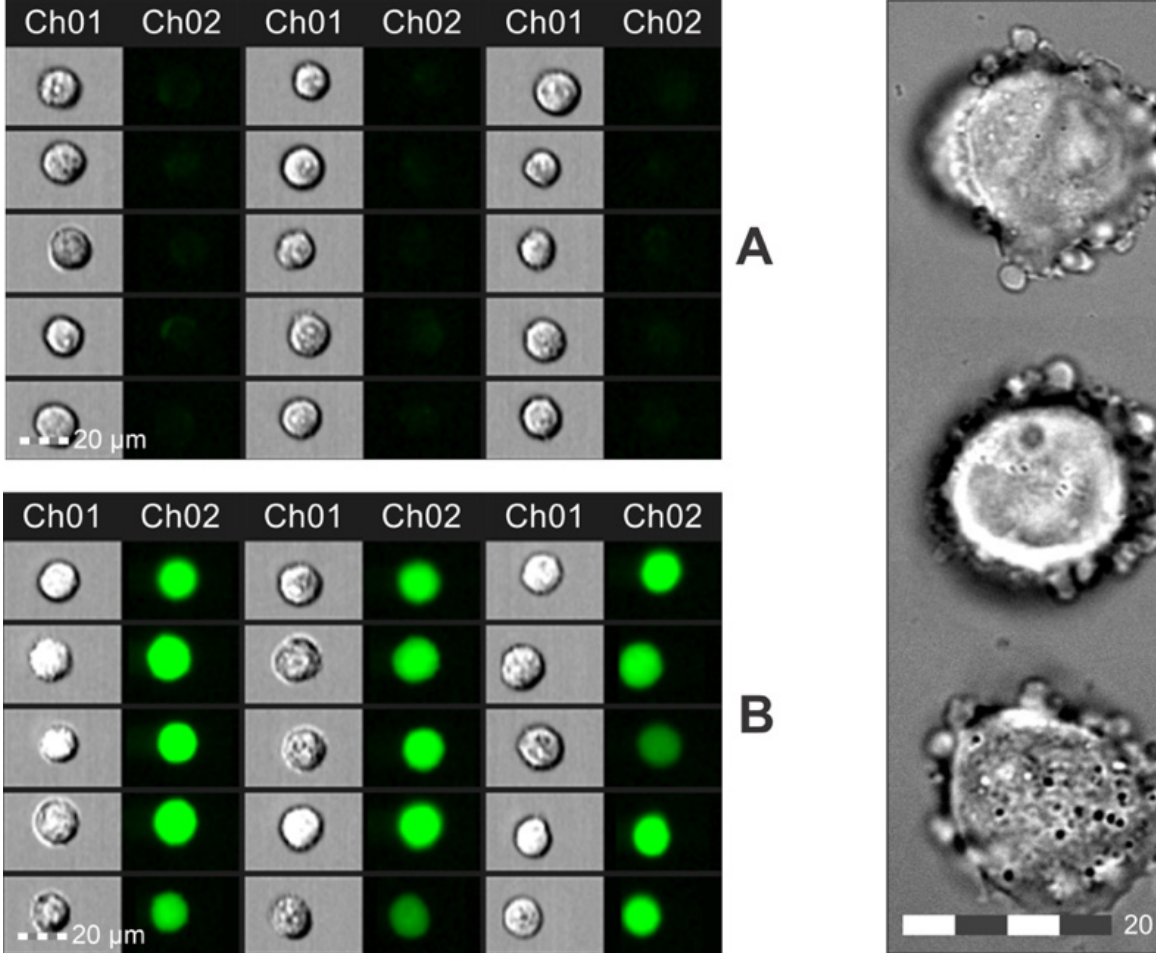
Figure 7. Photographs of cells 24 h post-electrotransfection, where ( A ) PEF nontreated control (plasmid only), 15 accidentally selected cells; ( B ) cells treated with 7 kV/cm × 300 ns × 100 pulses (1 MHz), 15 accidentally selected cells; ( C ) images of cell swelling and blebbing after PEF treatment captured using 60 × UPlanSApo oil objective (NA = 1.35) on an Olympus IX81 microscope (Olympus, Hamburg, Germany). Ch01—brightfield images and Ch02—fluorescence images using a laser of 488 and 505–560 nm BP filter.